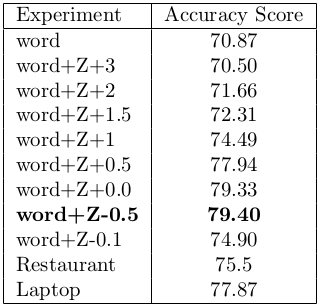
Table from the paper: Sentiment Analysis in Scholarly Book Reviews
Table text:
Experiment
AccuracyScore
word
70.87
word+Z+3
70.50
word+Z+2
71.66
word+Z+1.5
72.31
word+Z+1
74.49
word+Z+0.5
77.94
word+Z+0.0
79.33
word+Z-0.5
79.40
word+Z-0.1
74.90
Restaurant
75.5
Laptop
77.87